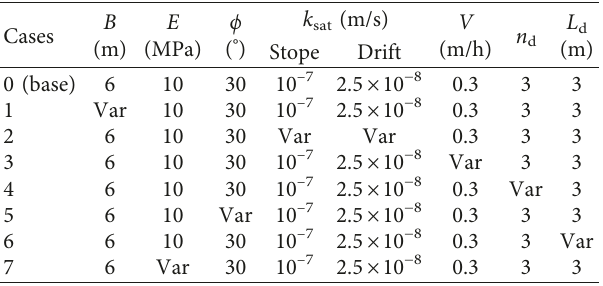
Table 1: Characteristics of the numerical simulations with the 20kN/m 3 , μ defined by various parameters used (with c sat (cid:31) equation (1), and H (cid:31)